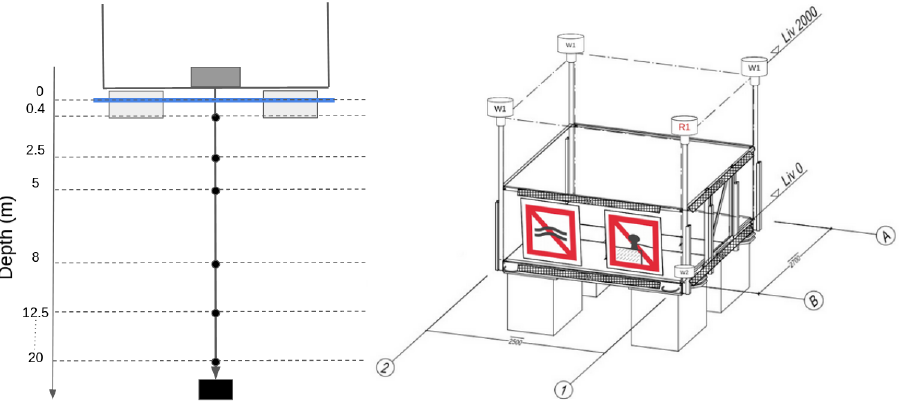
Figure 3. On the left, the design of the position of the chain sensors; on the right, the project of the platform designed and realized by Officine Ghidoni SA (Via al Pizzante 9, 6595 Riazzino, Switzerland). The AHFM system, mounted on a customized structure fixed on the center of the platform, is composed of three main units (Figure 4): the power unit; the sensor unit; and the main